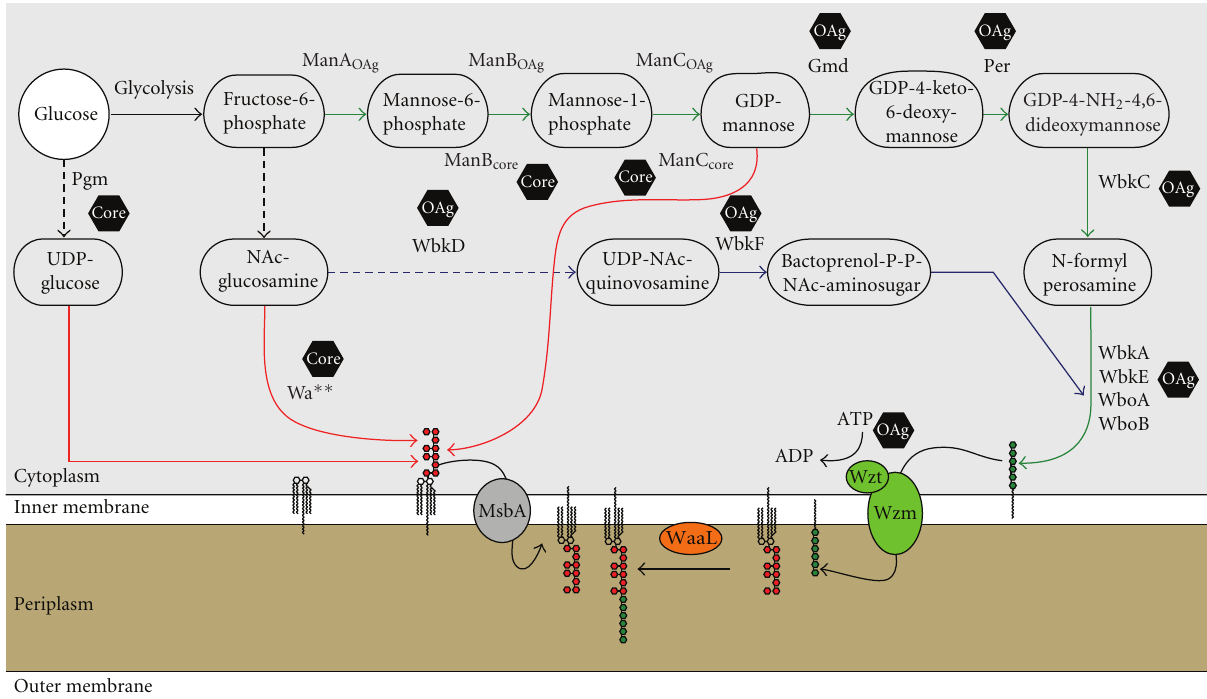
Figure 4: Predicted pathways of LPS O-antigen and core molecule biosynthesis. Brucellae derive all sugars from glucose. Green arrows indicate the reactions leading to the synthesis of the monomeric O-antigen subunits, which are polymerized onto bactoprenol (pathway indicated in blue). The complete O-antigen is then transported to the periplasmic face of the inner membrane by the ABC transporter system Wzm/Wzt and ligated to lipid A molecule by the O-antigen ligase WaaL. Pathways leading to the biosynthesis of the core molecule are indicated in red. Hexagons indicate whether mutants in the respective genes are a ff ected in the biosynthesis of the O-antigen (OAg) or the sugar core molecule (Core). Dotted arrows indicate abbreviated pathways involving the defined